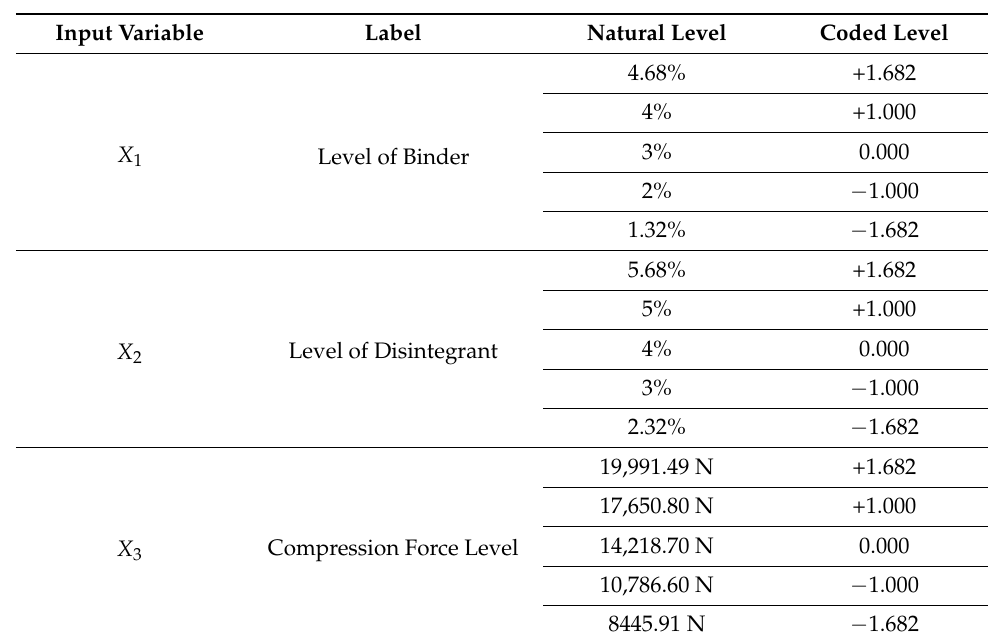
Table 2. Input Variables (Factor’s